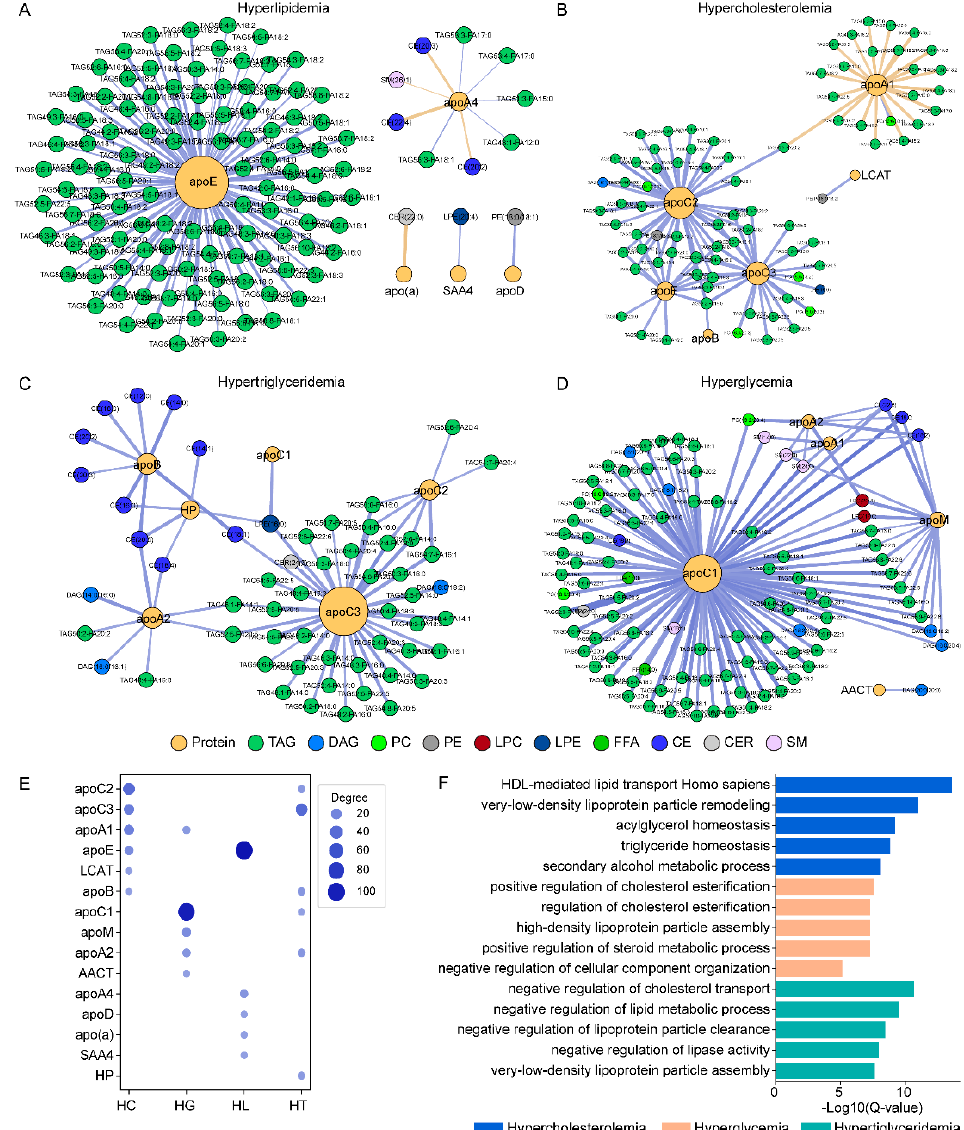
Figure 4. Topological networks constructed based on correlations between lipid and protein con- centrations. Networks were constructed for ( A ) hyperlipidemia ( B ) hypercholesterolemia ( C ) hy- pertriglyceridemia and ( D ) hyperglycemia by the selection of lipid–protein pairs based on the ab- solute value of Pearson correlation (r > |0.5|) and the significance of the up- or down-regulation to the control samples ( p -value < 0.05). Proteins are shown as orange circles, and the size of the circles is proportionate to the number of correlating lipid species, colored by lipid classes. ( E ) Comparison of the number of lipid species correlated with hub proteins in each group. The protein-circle sizes reflect the number of lipid species correlated with each protein. ( F ) The top-5 biological pathways and processes that were uniquely enriched based on the sets of hub proteins in the networks of hypercholesterolemia, hyperglycemia, and hypertriglyceridemia samples.